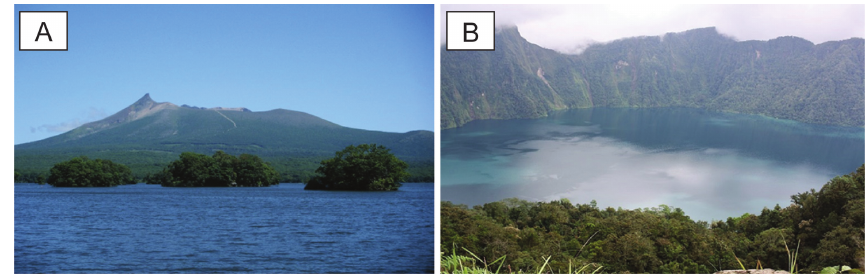
Figure 3. (a) Komaga-take volcano (Hokkaido, Japan) (source: Zelkova, CC BY-SA 3.0) as seen from Yakumo (in the NW); (b) Mount Parker (locally known as Mélébingóy), South Cotabato, Philippines (Source: Noriah Jane Lambayan, CC BY-SA